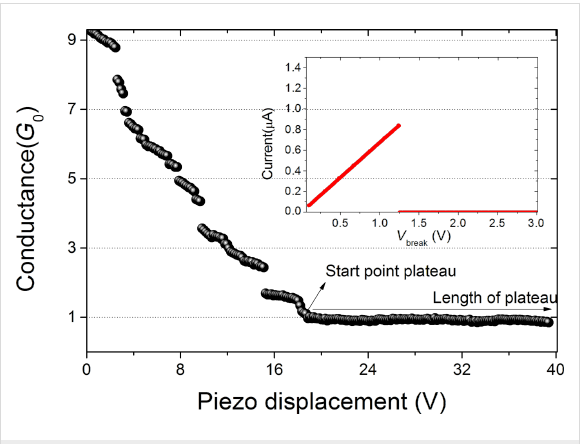
Figure 3: Example of a conductance breaking trace for Au. As soon as the conductance drops to the conductance of a single-atom junction, this point (arrow) is marked as the start of the formation of an atomic chain. Inset: Current vs bias voltage leading to breakup of the atomic chain at about 1.25